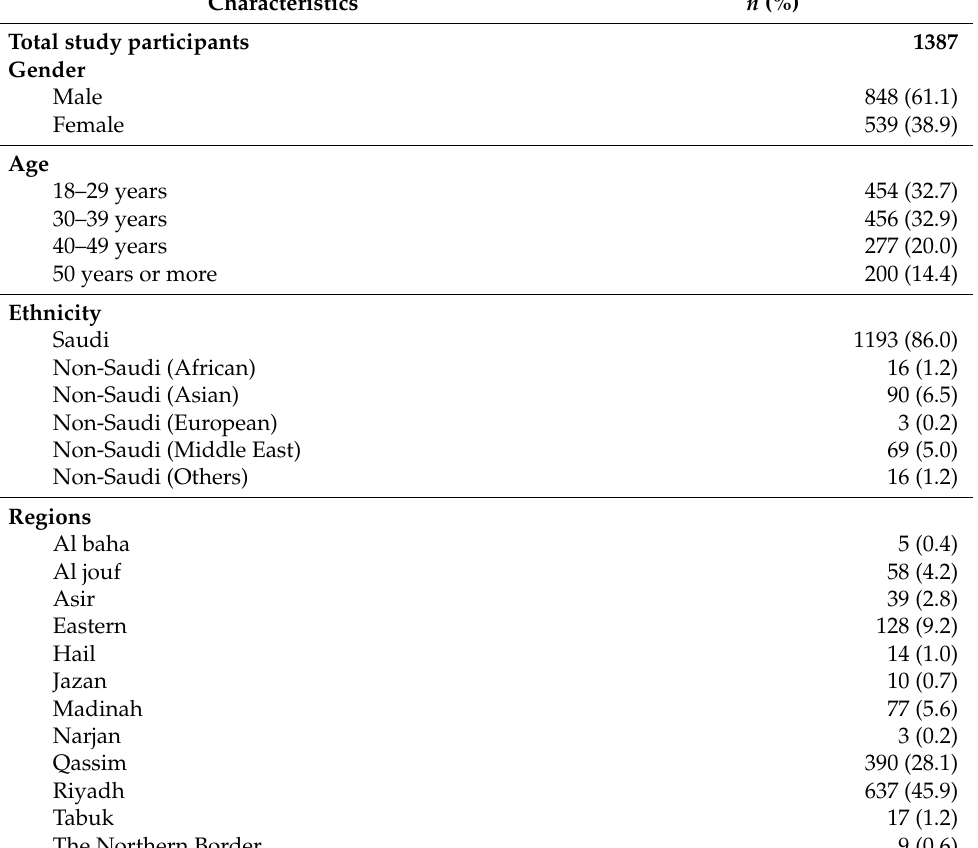
Table 1. Characteristics of the study